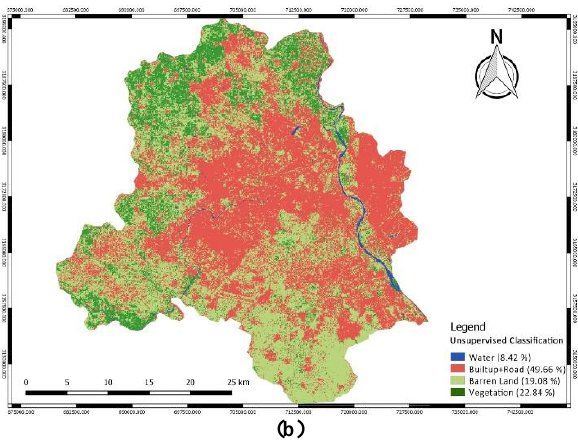
Figure 6 . (a) Composite image stacked from NDVI, NDWI, NDBI and NDSI; (b) Unsupervised classification using Normalized stacked Image